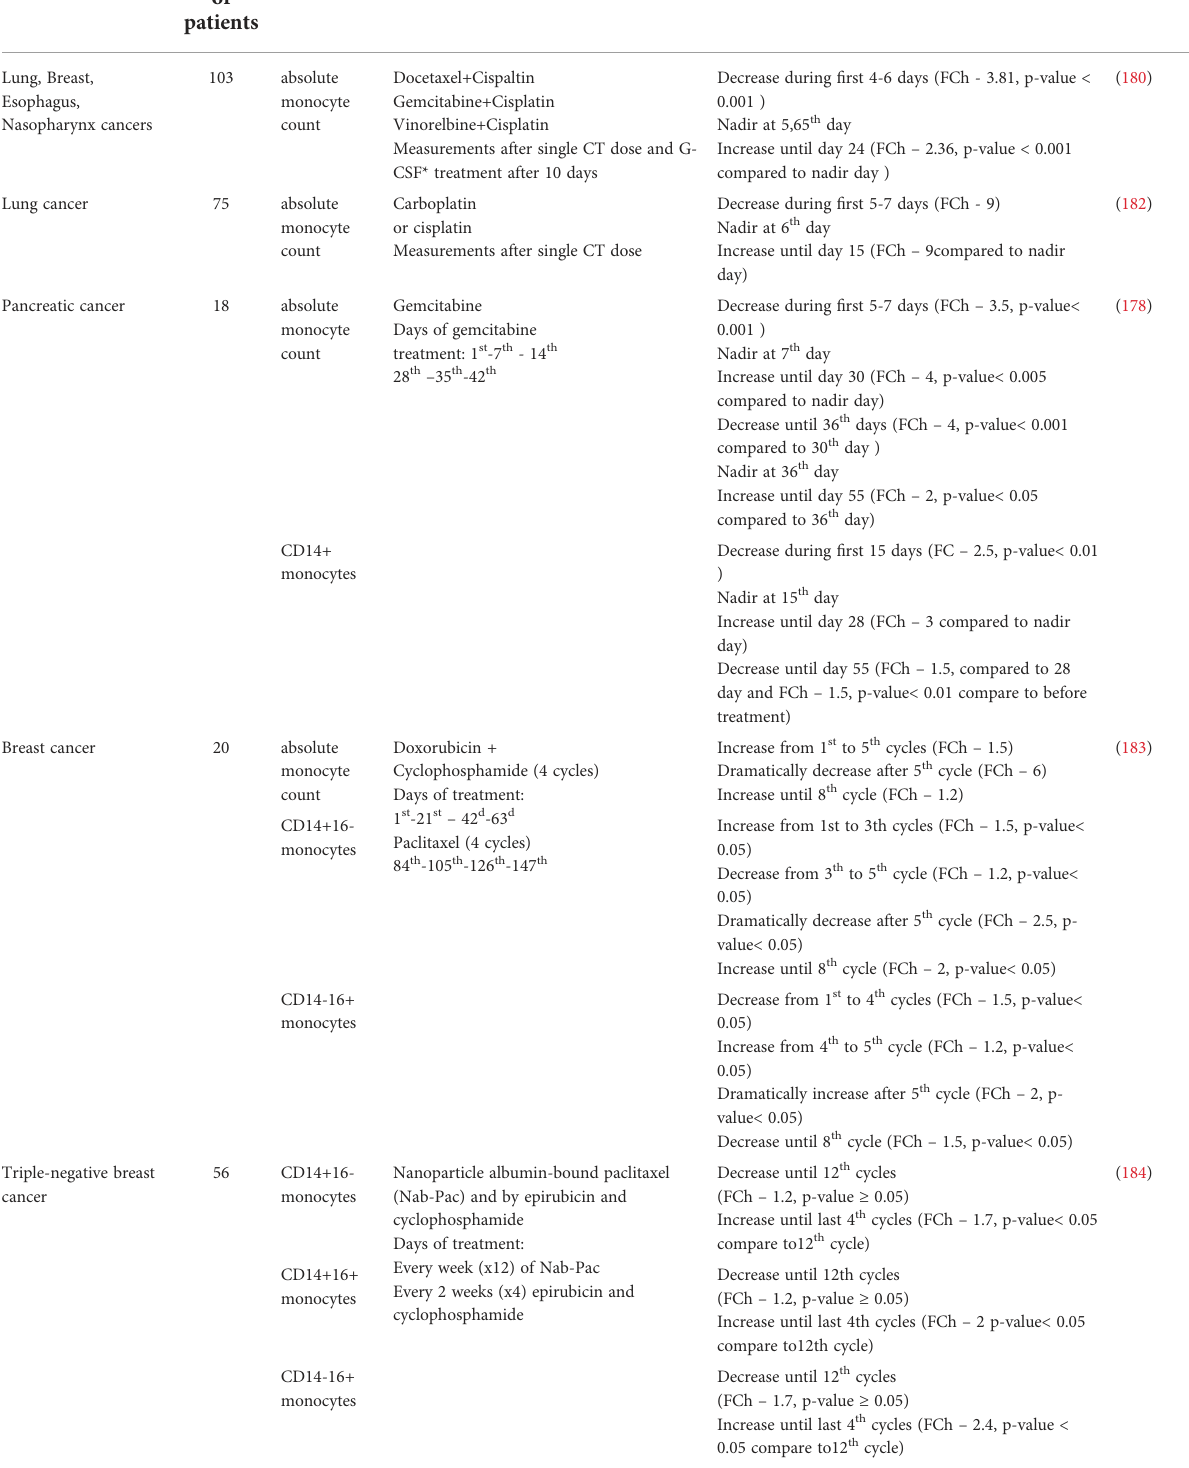
TABLE 2 Dynamics of circulating monocytes during chemotherapy in cancer